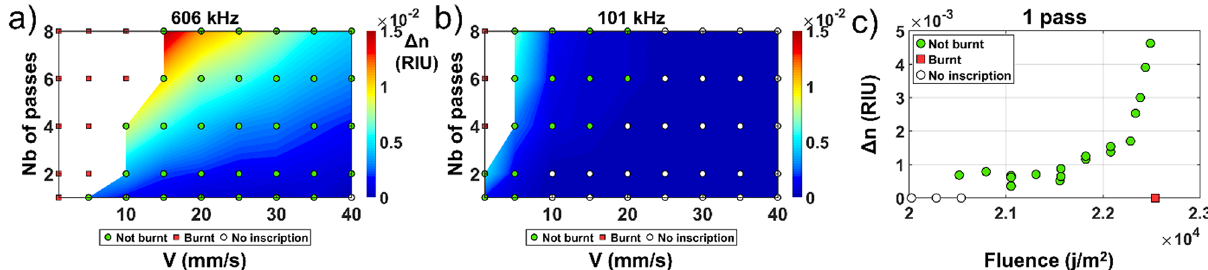
Figure 5. Fs laser induced refractive index change in PDMS-Bp-Ge for various writing speed and numbers of passes at ( a ) 606 kHz and ( b ) 101 kHz. ( c ) Refractive index change evolution relatively to the fluence for one pass by varying the writing speed and/or the repetition rate